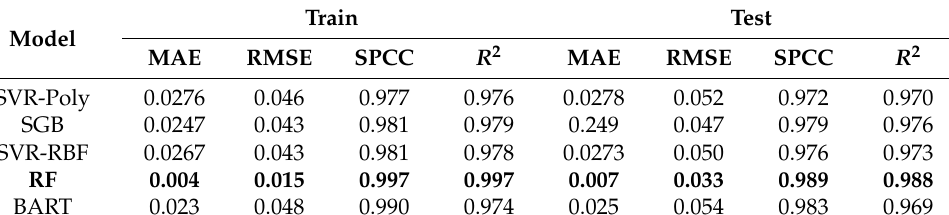
Table 10. Training and independent test performances of five generalized models. Train Model